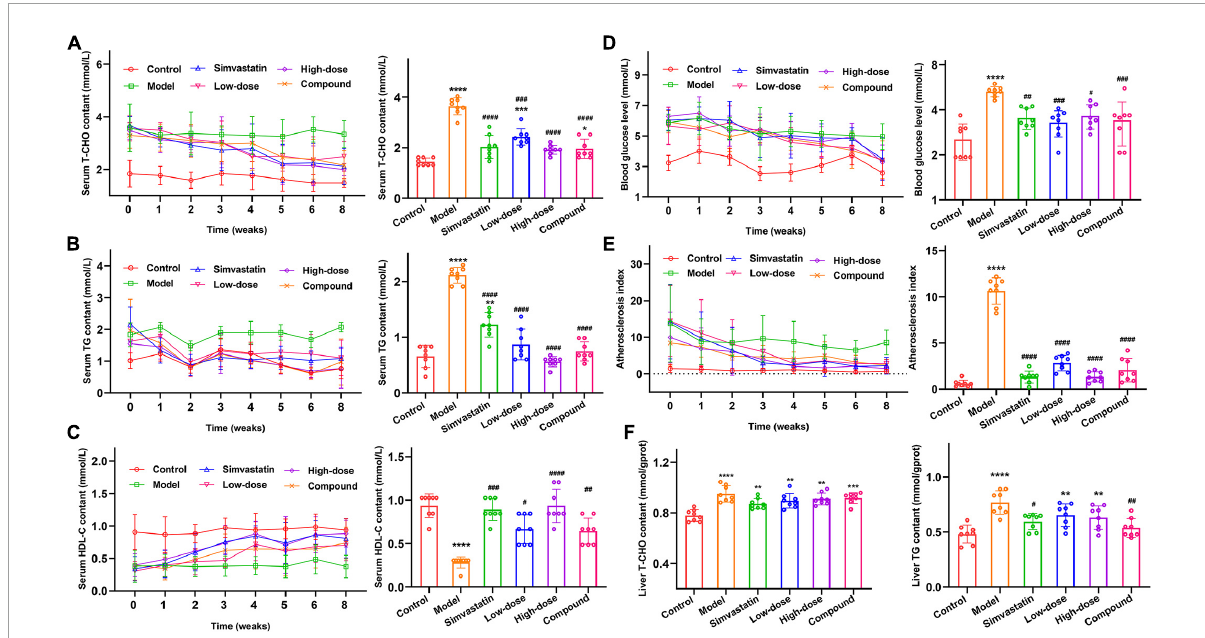
FIGURE3 Effect of HFA on lipids in serum and liver of hyperlipidemic rats. (A–E) Changes in T-CHO, TG, HDL-C, GLU, and AI in rat serum during 8 weeks. (F) Changes in T-CHO and TG levels in rat liver homogenates. Data represent mean ± SD ( n = 8). Statistically significant results were indicated as